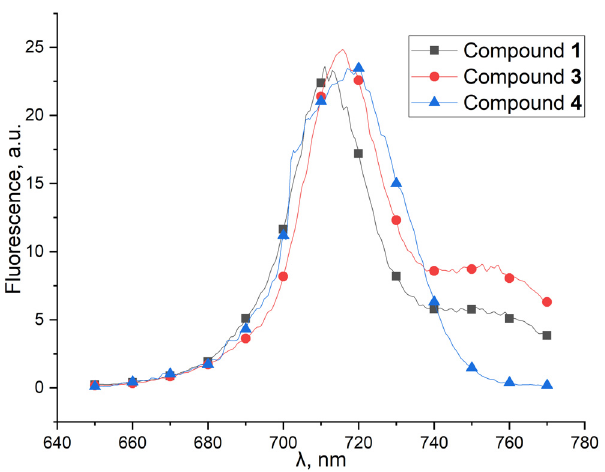
Figure 2. Fluorescence spectra of compounds ( 1 ), ( 3 ), and ( 4 ). The fluorescence spectra were obtained at the same solution concentrations, with dichloromethane as a solvent (excitation wavelength 520 nm).